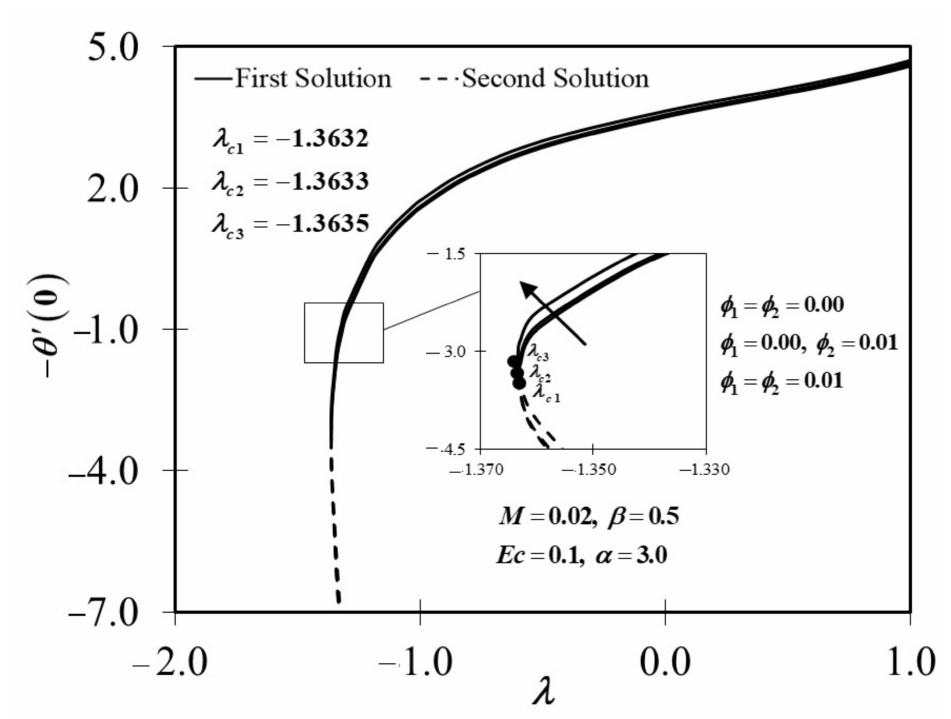
Figure 3. − θ (cid:48) ( 0 ) versus λ with specific φ